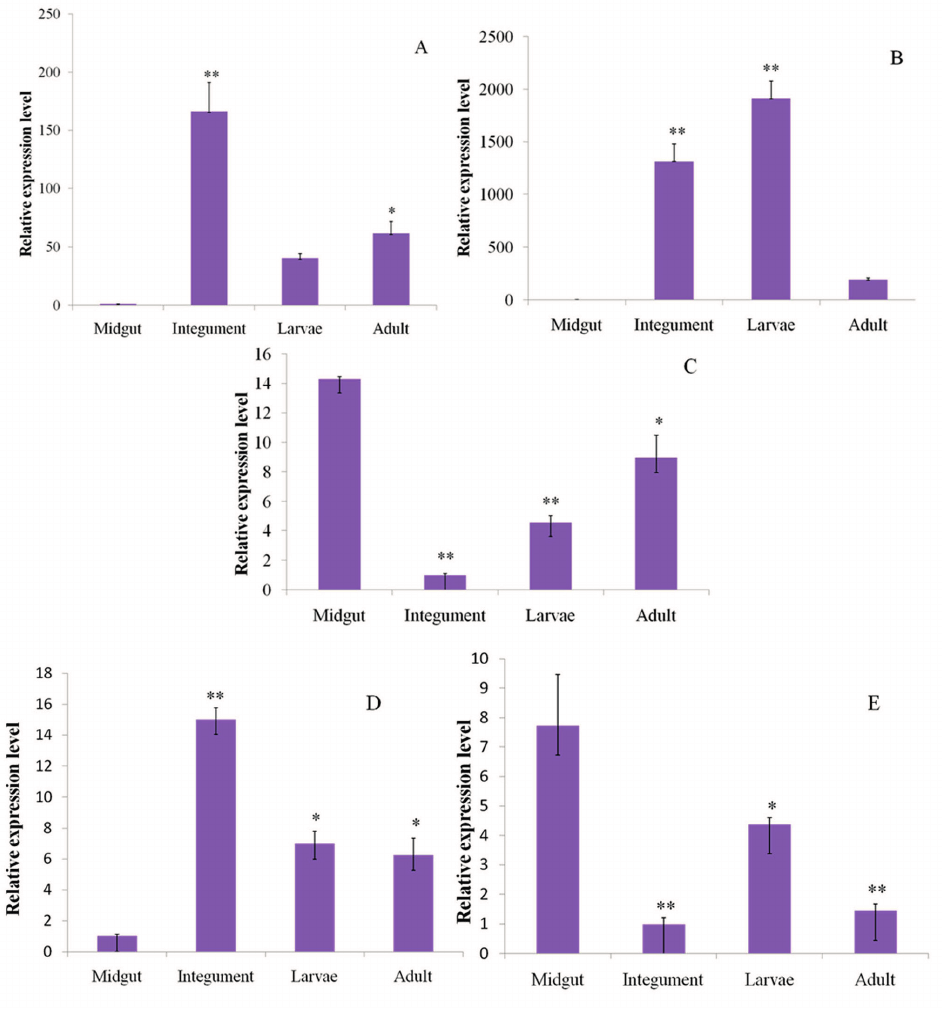
Figure 5. Real-time PCR analysis of the transcripts putatively encoding chitin metabolism enzymes and detoxification-related enzymes in C. medinalis . ( A to E refer to relative expression level of C. medinalis chitin synthase 1 ( CmCHS1 ), chitinase 1 ( CmCHT1 ), chitin deacetylase 1 ( CmCDA1 ), cytochrome P450 monooxygenase CYP9A79 ( CmCYP9A79 ) and glutathionine S -transferase ( CmGST ). * p < 0.05, ** p <